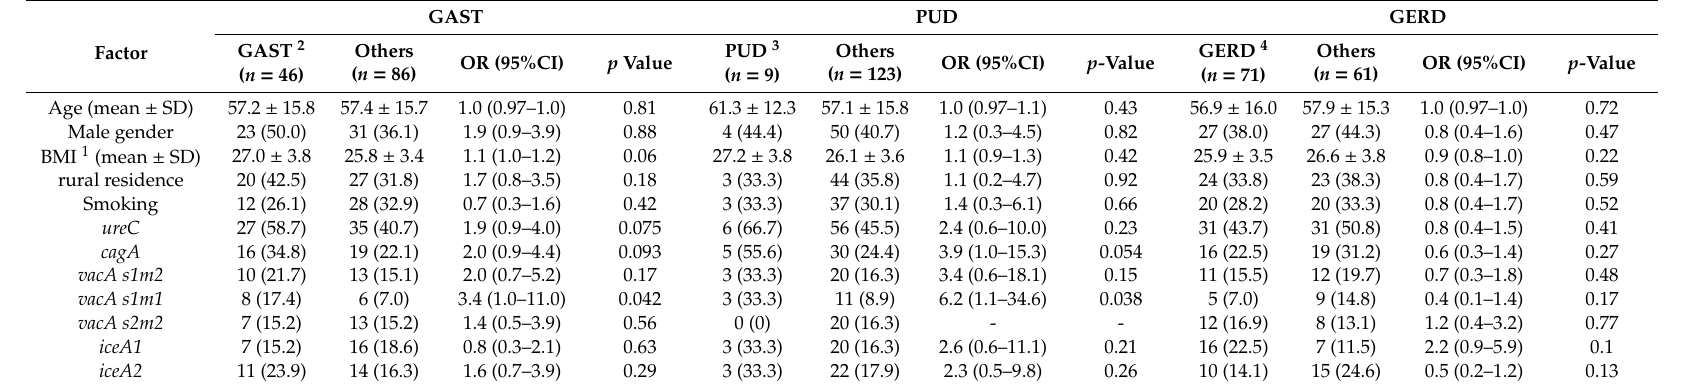
Table A1. Univariate analysis of factors associated with clinical